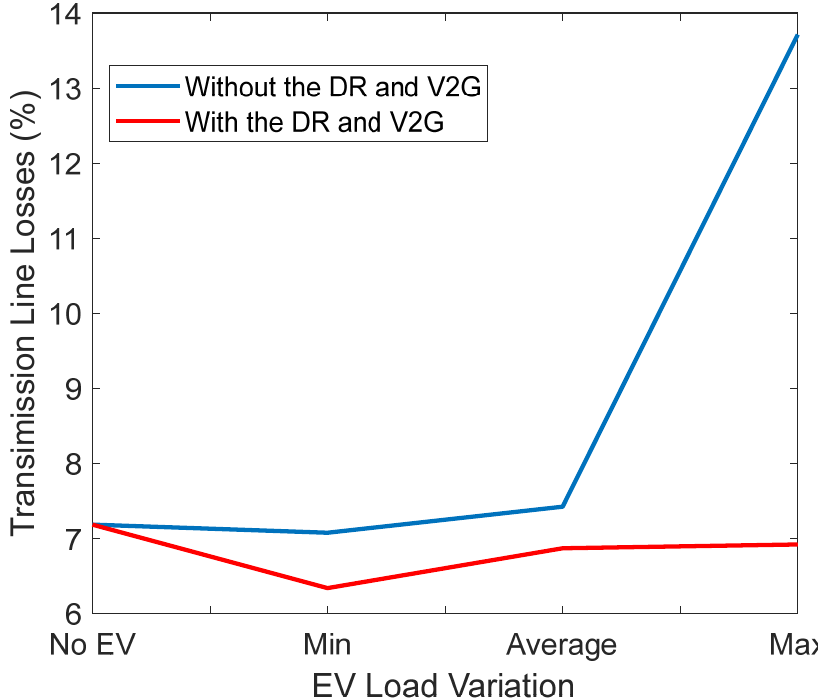
Figure 13. The variation of the transmission line losses with and without the use of DR and V2G.